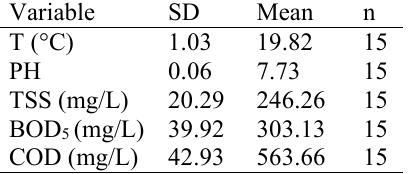
Table 1. Typical characteristics of raw municipal wastewater of Tafresh